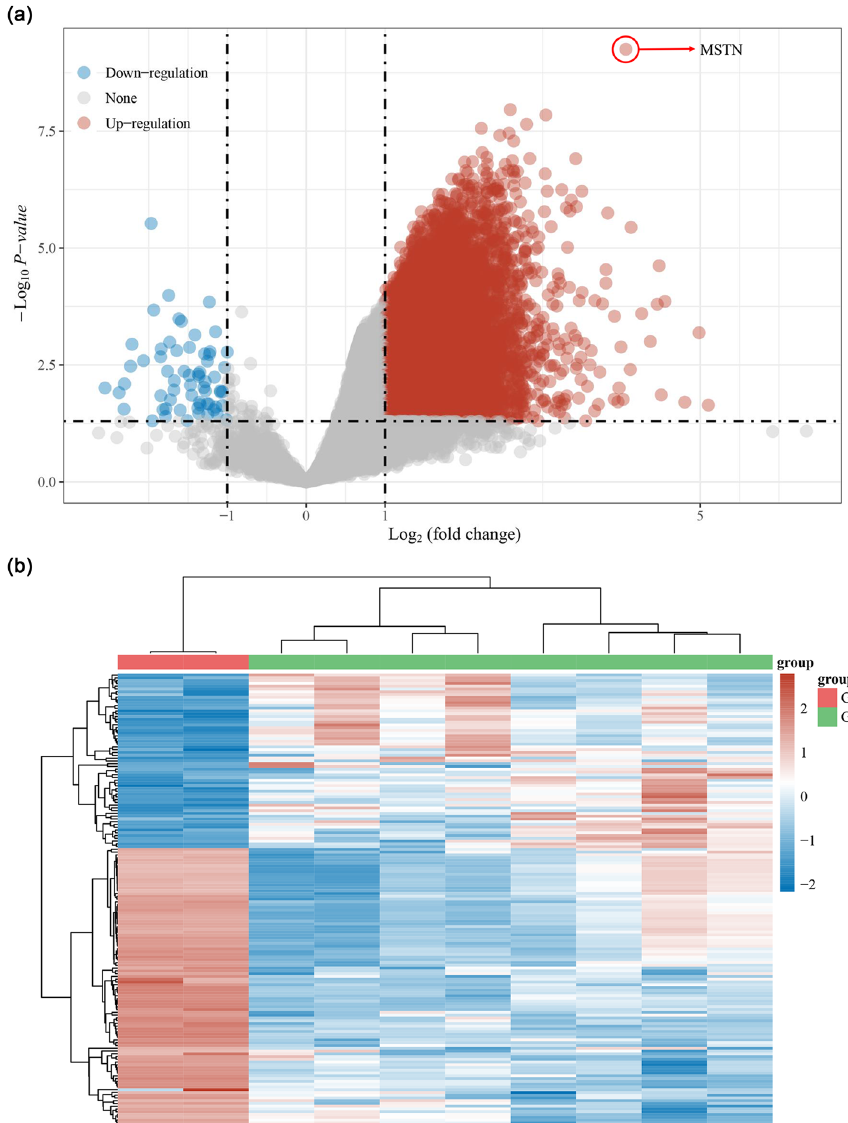
Figure 1: Di ff erentially expressed genes in GSE73953 dataset. ( a ) Volcano map of di ff erentially expressed genes in GSE73953 dataset. Fold change represents the degree of gene upregulation or downregulation in the dataset, while the dash - dotted lines are used to distinguish the genes (| logFC | > 1 ) . p < 0.05. ( b ) Heat map of di ff erentially expressed genes in GSE73953 dataset. G1 group represents the peripheral blood mononuclear cells from 16 healthy controls, while G2 group refers to peripheral blood mononuclear cells from eight membranous nephropathy patients. Each row denotes di ff erent samples in G1 and G2 groups, and each column represents di ff erential genes in the G1 and G2